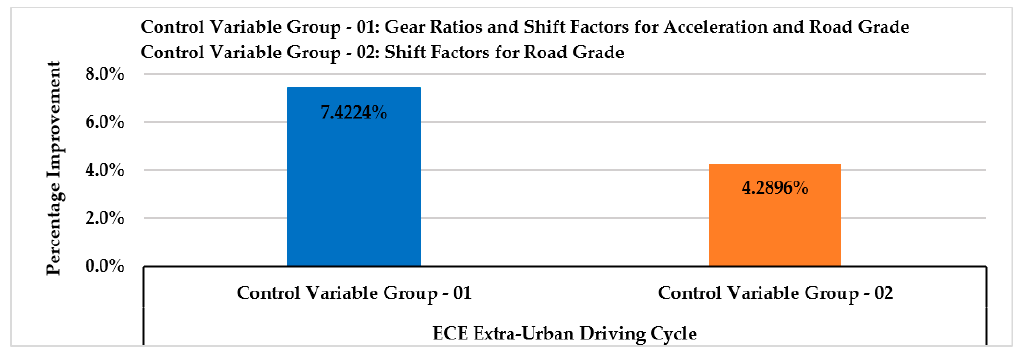
Figure 15. Energy saving through the optimization of gear ratios and shift factors of a gearshift schedule for acceleration and road grade for a two-speed transmission system in an EV model on the ECE Extra-Urban driving cycle with varied road grade.